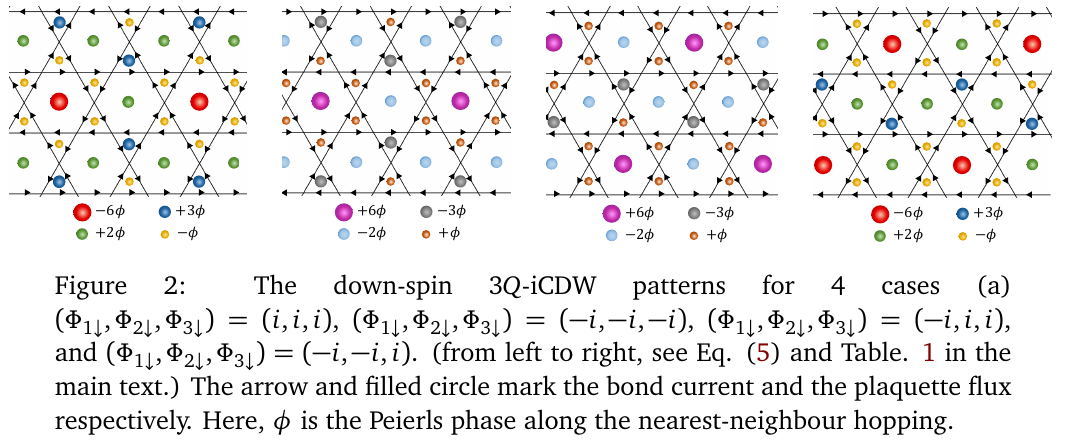
) = ( − i , i , i ) , , Φ , Φ 1 ↓ 2 ↓ 3 ↓